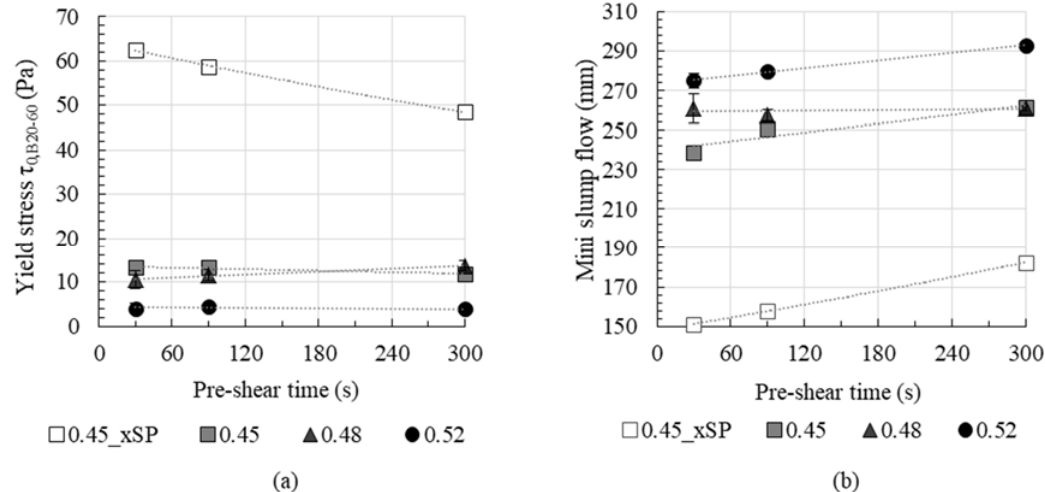
ff ect of pre-shear time on yield stress ( a ) and mini-slump flow after shear ( b Figure 9. Effect of pre ‐ shear time on yield stress ( a ) and mini ‐ slump flow after shear ( b ). Figure 9. E